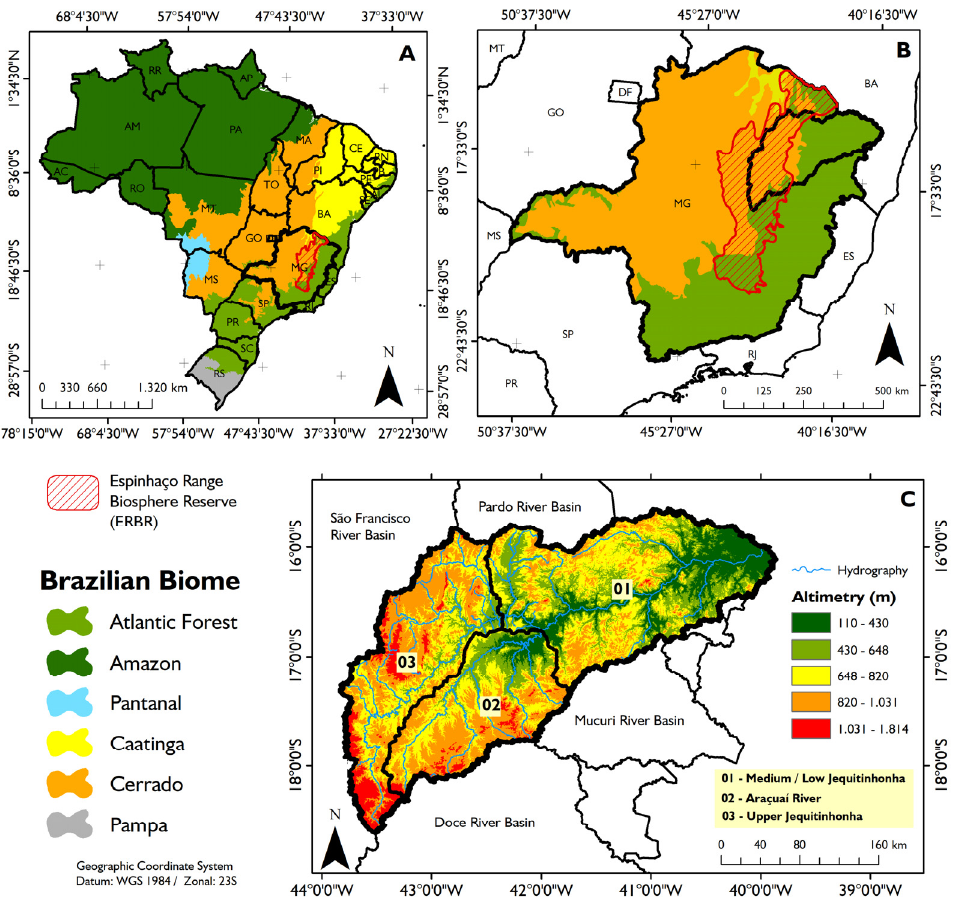
Figure 1 . Location of the study area in the context of the biomes of Brazil ( A ) and the state of Minas Gerais ( B ). Altimetry of the Jequitinhonha River Hydrographic Basin (JRHB) and the main tributaries and border basins ( C ).